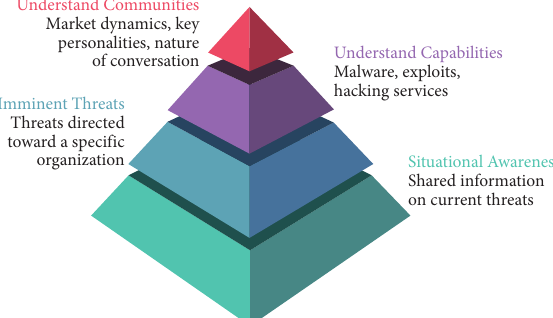
Figure 1: Tiers of Cyber Threat Intelligence (CTI) as classified by Paulo Shakarian [23].